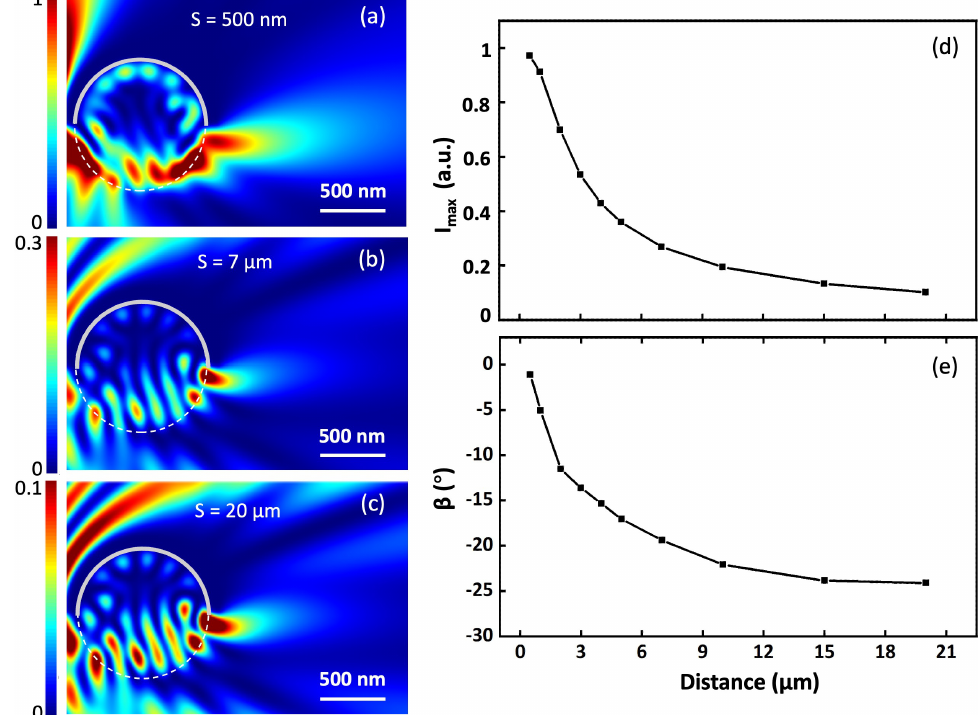
Figure 5. Optical fields of the patchy microcylinders with a diameter of 1 µ m under point-source illumination at different source distances: ( a ) S = 500 nm, ( b ) S = 7 µ m, ( c ) S = 20 µ m. ( d ) Maximum intensity enhancement factor I max . ( e ) Bending angle β